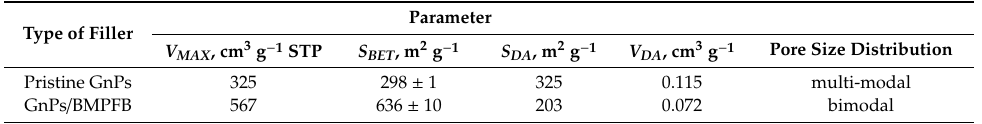
Figure 2. Density functional theory pore size distribution of pristine GnPs and after treatment by BMPFB. Table 3. The textural properties of pristine graphene nanoplatelets (GnPs) and GnPs modified with BMPFB from solution (GnPs /